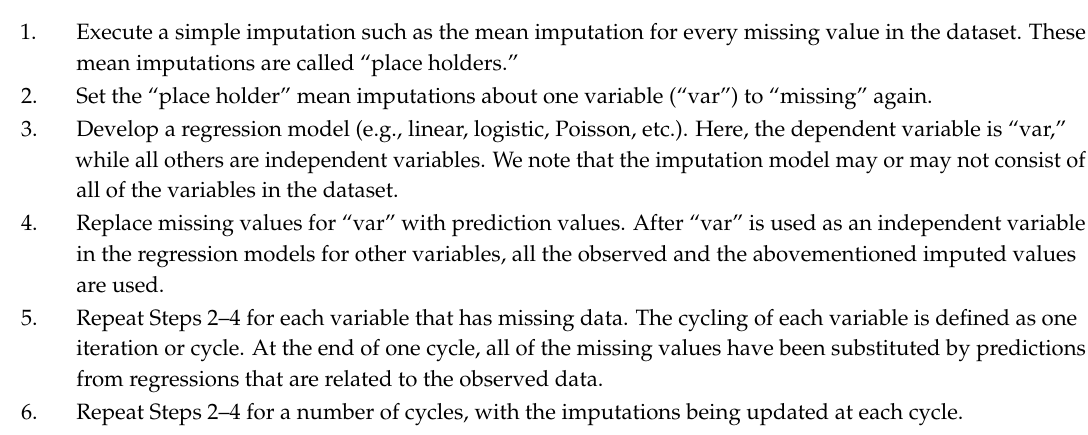
Algorithm 1: MICE algorithm for imputation of multivariate missing data